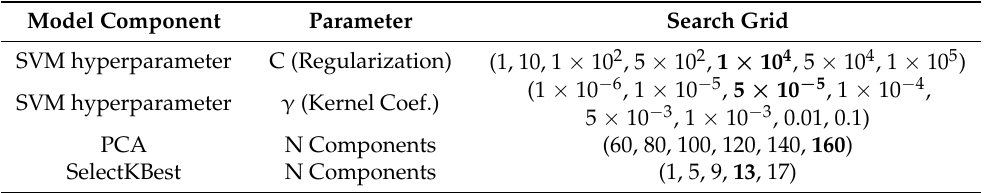
Table 2. Grid-search parameter space used to optimize the model. The model parameters associated with the best-fit model are in bold. (see Section